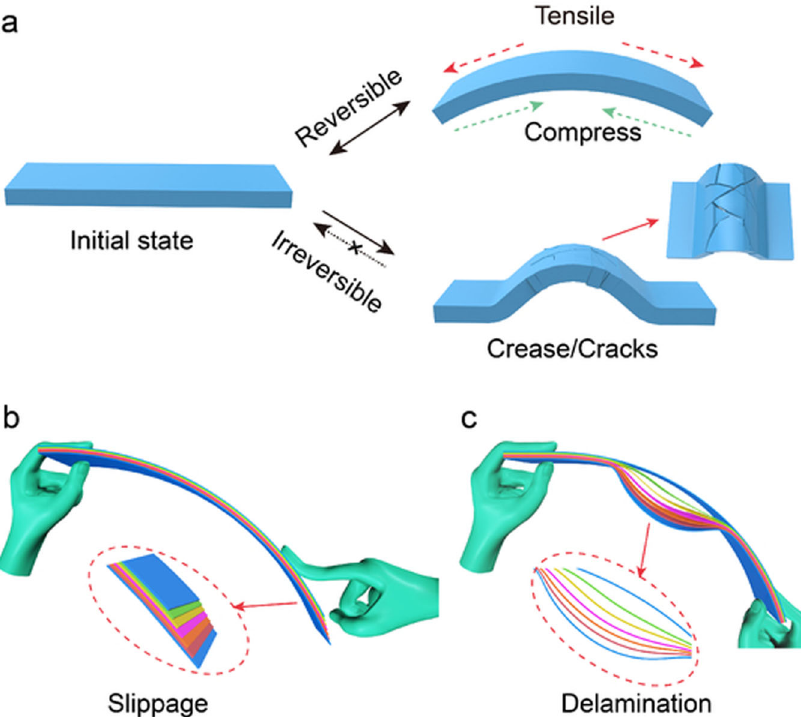
Fig. 1 Schematics of structural evolutions of single layer and full battery device under bending force. a Initial state and fi nal state of deformable single layer throughout reversible elastic deformation and irreversible plastic deformation. b In one-end fi xed bending of deformable batteries, slippage transiently occurs during elastic deformation and permanently exists after plastic deformation. c In two-ends fi xed bending of deformable batteries, delaminations transiently occur during elastic deformation and permanently exist after plastic